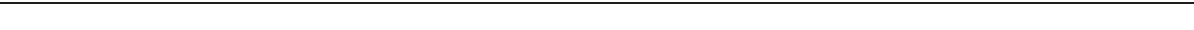
Fig. 6 Transfection of stem cells with mRNA nanoparticles can promote their expansion and self-renewal. a Targeting of CD105 enables speci fi c transfection of HSC CD34 + cells. Cells were left untreated, or transfected with eGFP-encoding mRNA in nanoparticles (NPs) coated with PGA coupled to a control antibody or anti-CD105. Transfection ef fi ciency was assayed by fl ow cytometry after 24 h. b NP transfection ef fi ciency in CD34 + samples from three independent donors. Viability is shown in c . d Expansion of CD34 + PBSCs after NP-transfection. e Phenotypical characterization of PBSC-derived CD34 + subpopulations after 2 days in culture. Cells were either transfected with eGFP NPs on day 1 or left unmodi fi ed. Gating is indicated in brackets on top of each column. f Summary bar graph showing mean frequencies and SE of primitive Hematopoietic Stem Cells (HSCs), Multipotent Progenitors (MPPs), Lymphoid-primed Multipotent Progenitors (LMPs), and Early Myeloid Progenitors (EMPs). PBSCs from four independent donors were analyzed. Error bars represent mean ± SE. g Colony output of sort-puri fi ed GFP-NP transfected versus unmodi fi ed CD34 + cells from day 7 cultures ( n = 3 cultures from independent donors); n.s., non-signi fi cant. Arising colonies were identi fi ed as colony forming unit (CFU) granulocyte (CFU-G), macrophage (CFU-M),